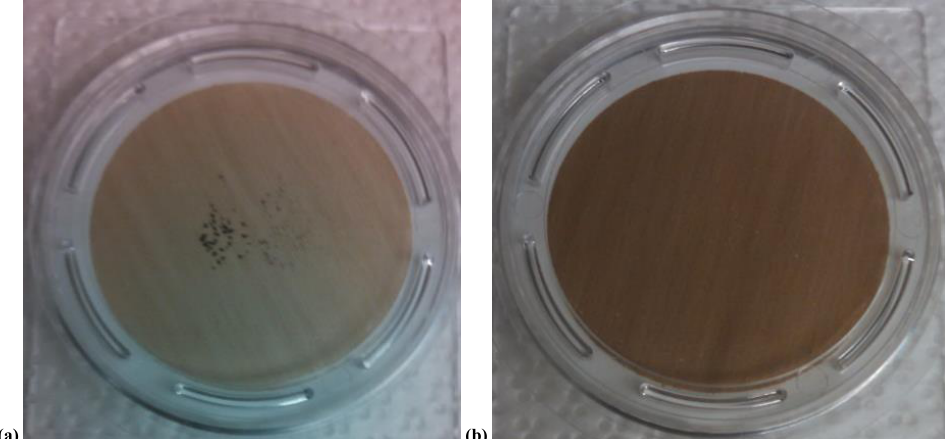
Figure 1. Filter (a) is from the higher-elevation, rural site (PEAV) and filter (b) is from the lower-elevation, urban site (UNRG) on 16 Septem- ber 2014. Aggregates were observed at PEAV but not at UNRG.